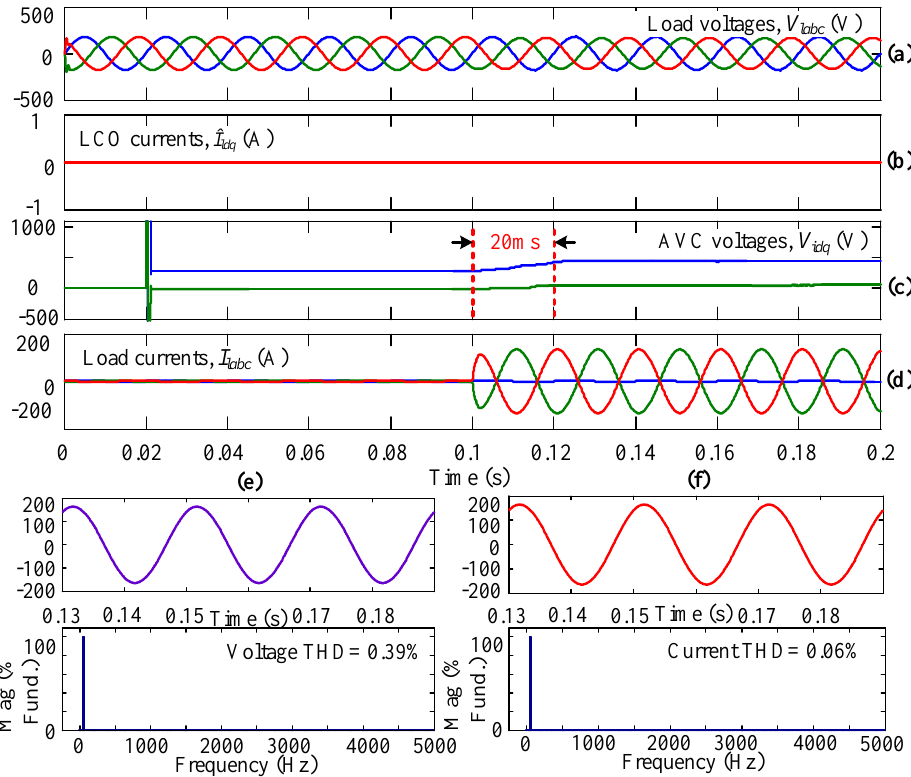
Figure 10. Simulation results for case-III with unbalanced load condition.